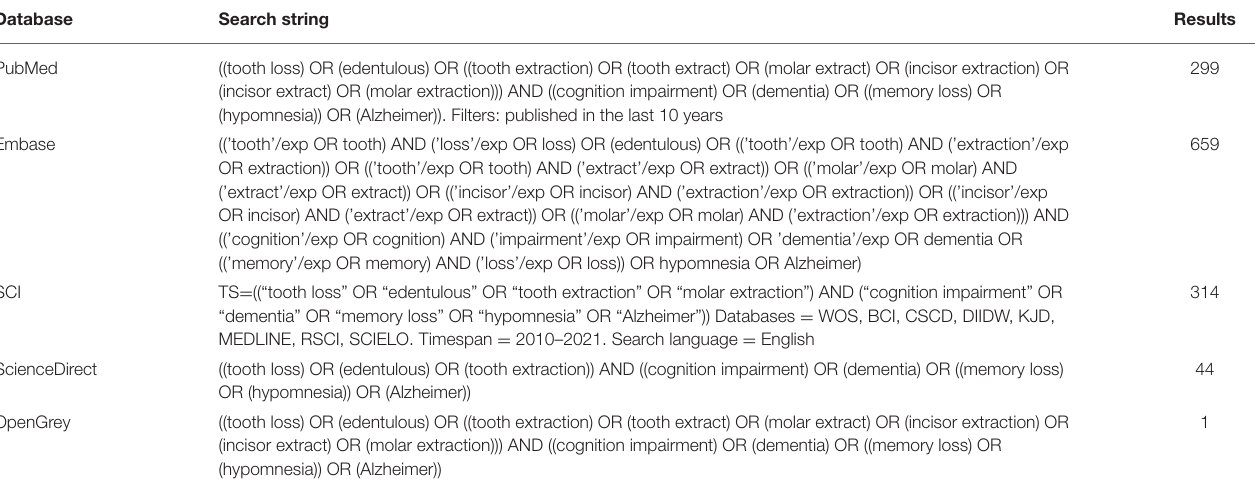
TABLE 1 | Search string.